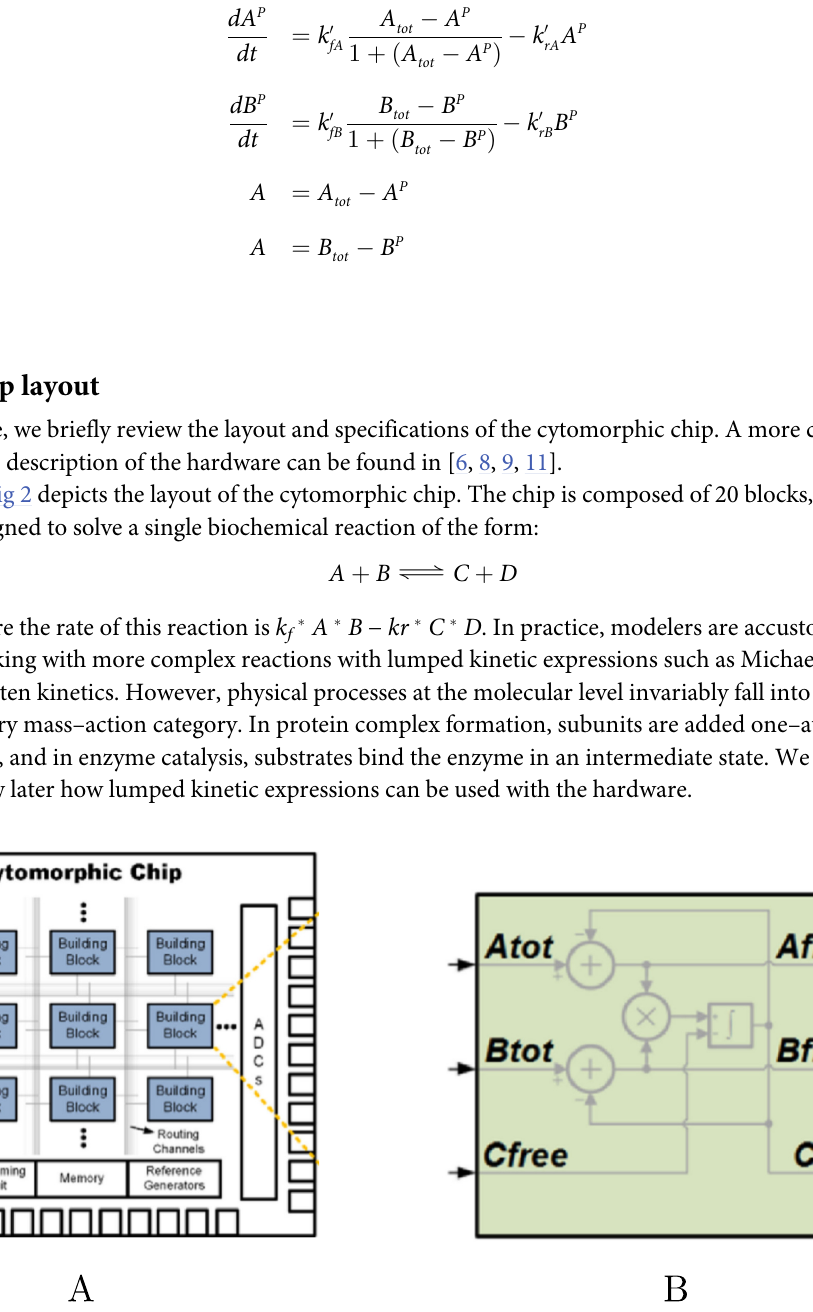
Fig 2. Layout of the cytomorphic chip. The chip is composed of 20 blocks of reaction units (A). Each block accepts as input total quantities for reactants A tot and B tot and outputs the total amount of product C tot , as well as any remaining “free” reactant A free and B free which has not yet been converted into product. These current–based inputs and outputs are converted into digital signals before being sent outside the chip in order to prevent signal degradation.